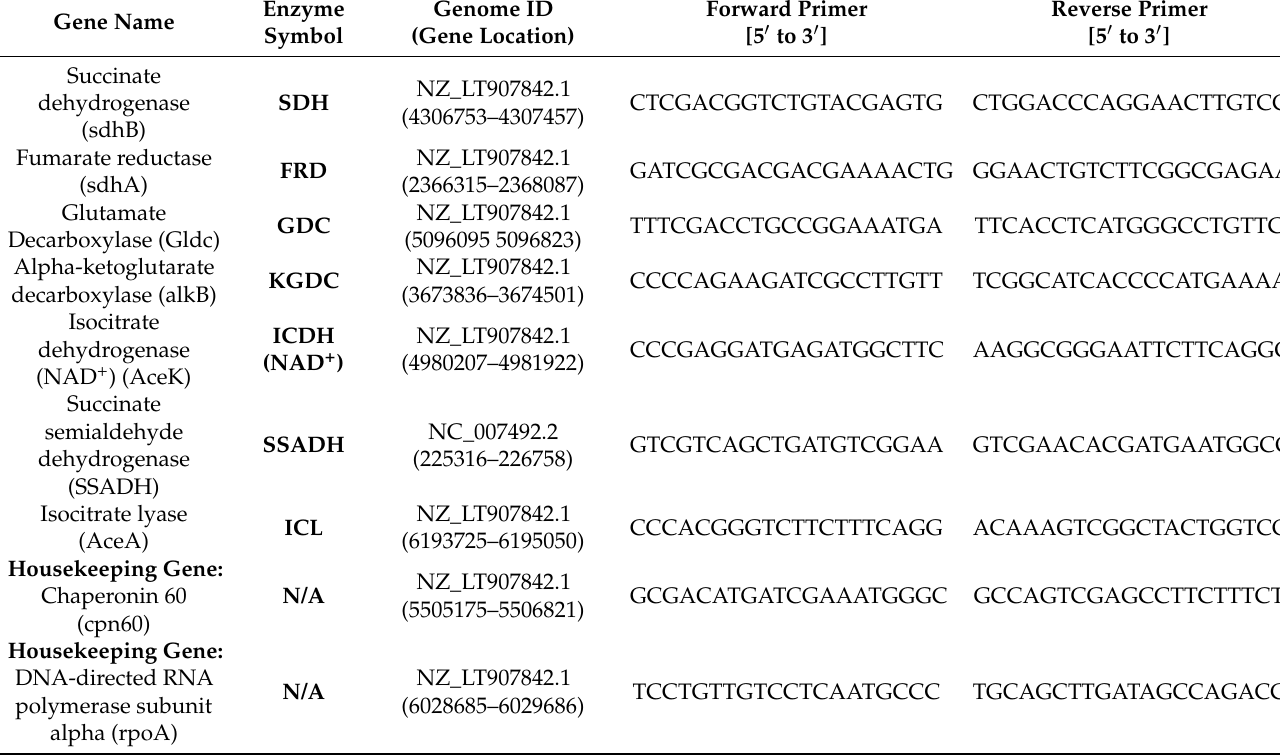
Table 1. List of primers used for the qRT-PCR